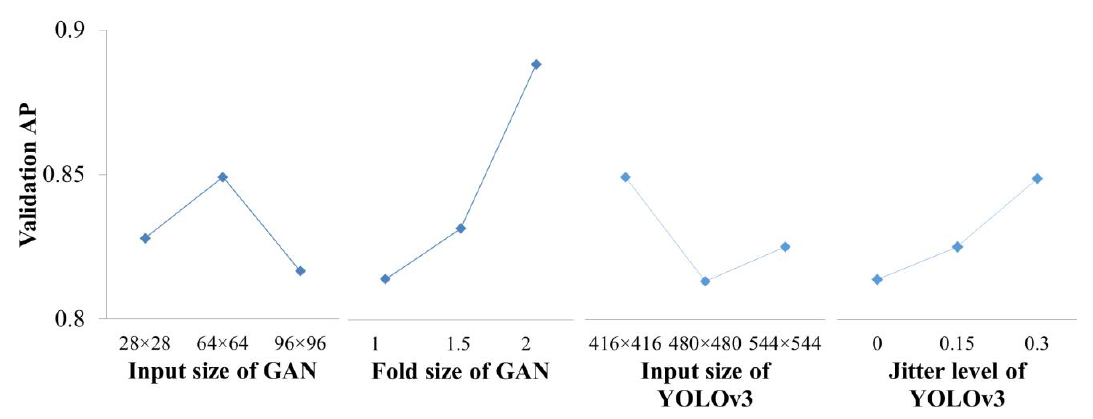
ff ect plot of 3 4 design of the experiment Figure 6. The main effect plot of 3 4 design of the experiment (DOE). Figure 6. The main e